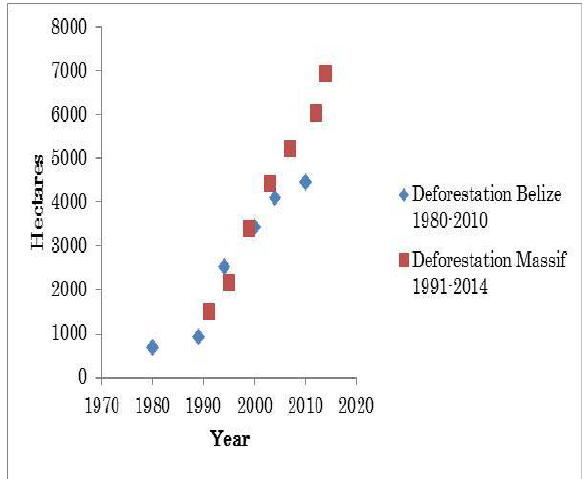
Figure 5. Accumulated deforestation comparison, Deforestation in Belize 1980-2010 and Maya Mountain Massif 1991-2014. The datasets are similar; especially in years where the time-steps are spaced one year apart, as is the case of 1994 & 1995, 1999 & 2000 and 2003 &